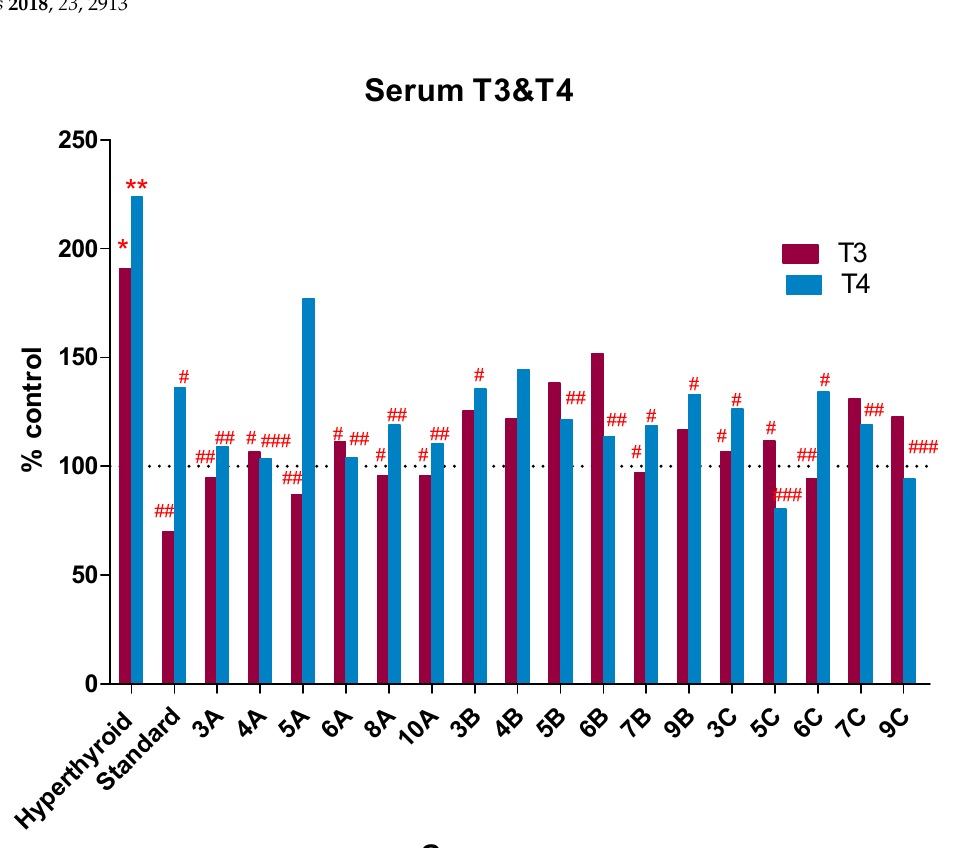
Figure 2. Effect of antithyroid derivatives on the mean serum levels of T3 and T4 in rats. Data are presented as the percentage in the control group. *: significant from the control group at p < 0.05. **: significant from the control group at p < 0.01 and 0.001. #, ## and ###: significant from Hyperthyroidism group at p < 0.05, 0.01 and 0.001, respectively.